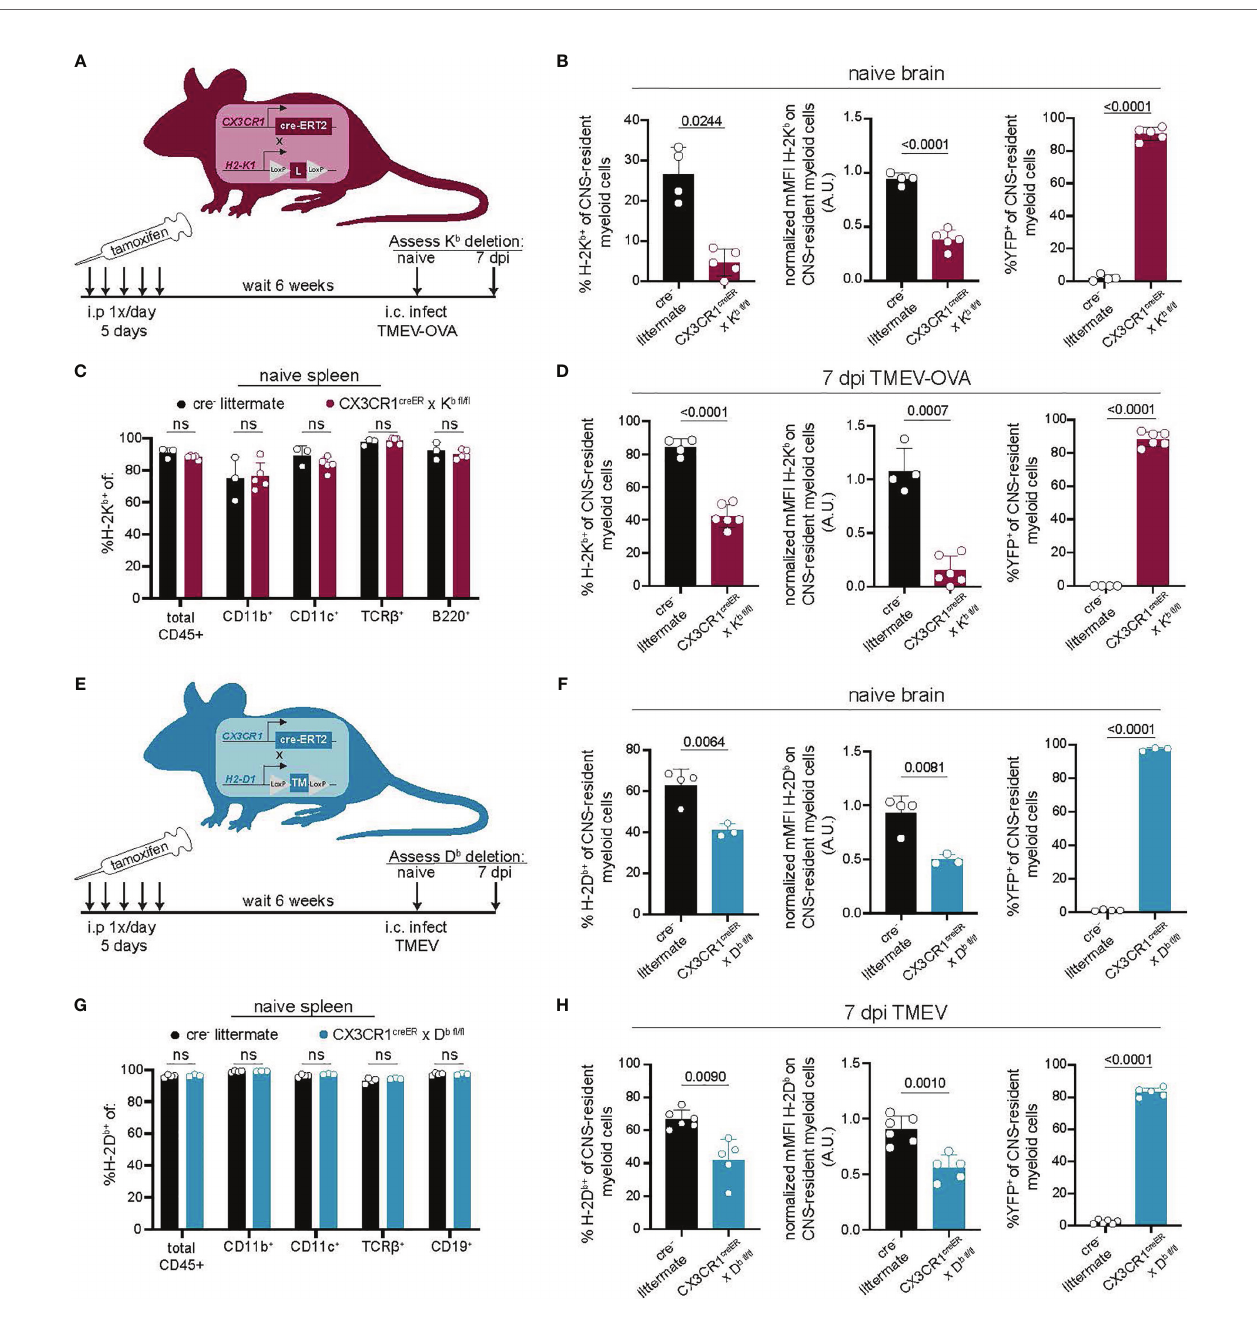
FIGURE 3 | Development of a model to conditionally delete MHC class I in CNS-myeloid cells. (A, E) MHC class I de fi cient CX3CR1 creER mice were crossed to transgenic H-2Kb fl / fl mice (14) (A) or H-2Db fl / fl mice (13) (E) . Tamoxifen was used to induce MHC class I deletion. After 6 weeks, K b /D b deletion was assessed using fl ow cytometry. (A – D) H-2K b expression by CNS-myeloid cells was quanti fi ed by measuring percent positive and normalized median fl uorescence intensity (MFI) in naïve CX3CR1 cre /K b mice and cre - controls. YFP expression was measured to assess penetrance of CX3CR1 creER transgene. (C) H-2K b expression was assessed in spleens of CX3CR1 cre /K b mice and cre - controls. (D) H-2K b expression by CNS-myeloid cells was quanti fi ed at 7 days post infection with TMEV expressing OVA 257-264 . (F) H-2D b expression by CNS-myeloid cells was quanti fi ed by measuring percent positive and normalized median fl uorescence intensity (MFI) in naïve CX3CR1 cre /D b mice and cre - controls. YFP expression was measured to assess penetrance of CX3CR1 creER transgene. (G) H-2D b expression was assessed in spleens of CX3CR1 cre /D b mice and cre - controls. (H) H-2D b expression by CNS-myeloid cells was quanti fi ed at 7 days post infection with TMEV. For all experiments, CNS-myeloid cells are live, single cells, expressing CD45 mid CD11b + CX3CR1 + . Data are shown as individual mice with mean from one independent experiment (n=3-6) of ≥ 3 experimental replicates. Error bars represent standard deviation. Two tailed Welch ’ s t test was used to assess statistical signi fi cance with ns p ≥